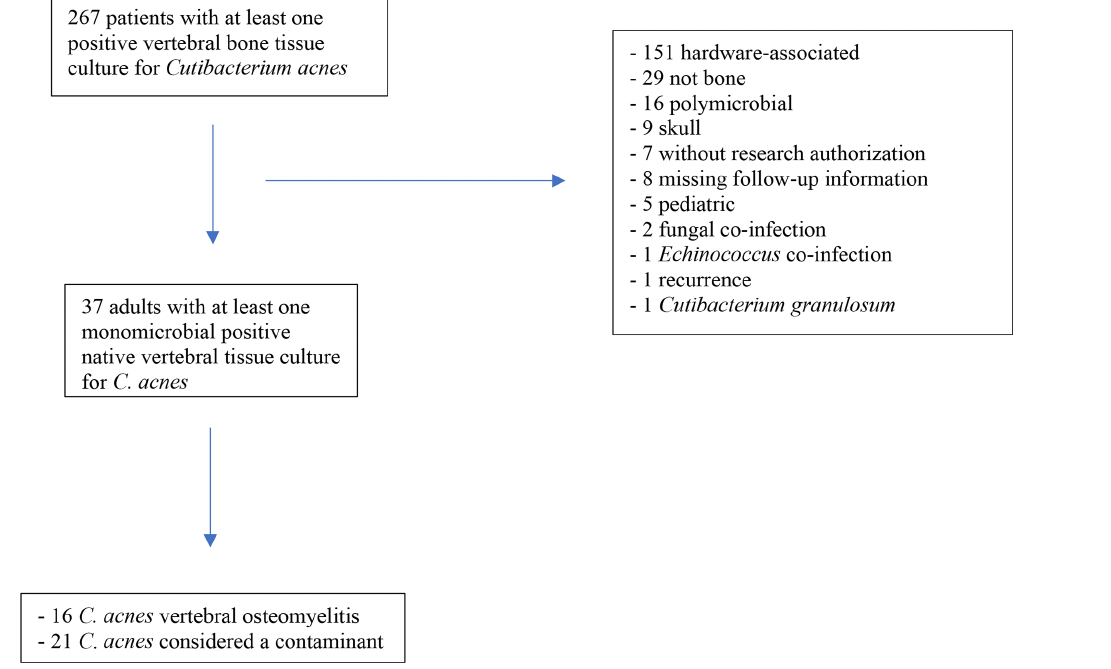
Figure 1. Cases of Cutibacterium acnes in spine tissue at Mayo Clinic between 2011–2021.